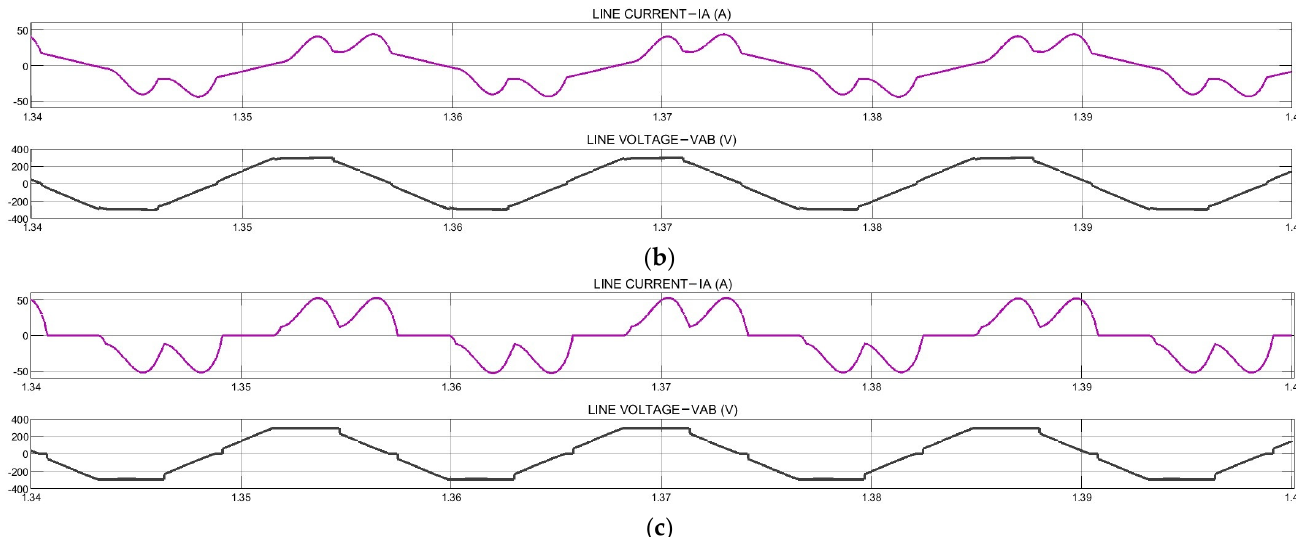
Figure 15. Steady-state currents and voltages: ( a ) Motor with variable speed drive; ( b ) case 1: one pump with a variable speed drive and the other with a direct connection to the grid; ( c ) case 2: both pumps with variable speed drive. The three scenarios at nominal speeds. The short circuit power of the source is 450 kVA, and the X/R ratio is 10.